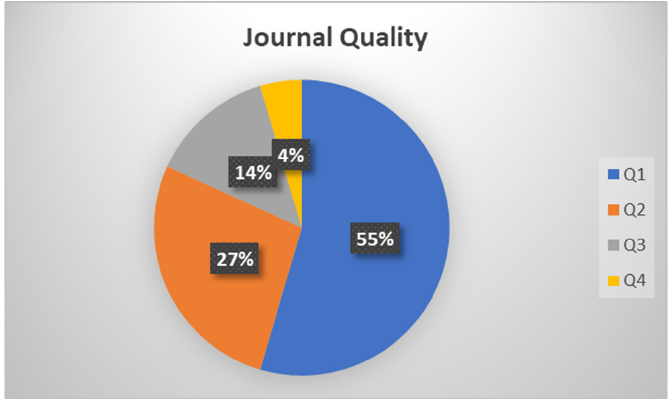
Figure 6. Quality of journals .